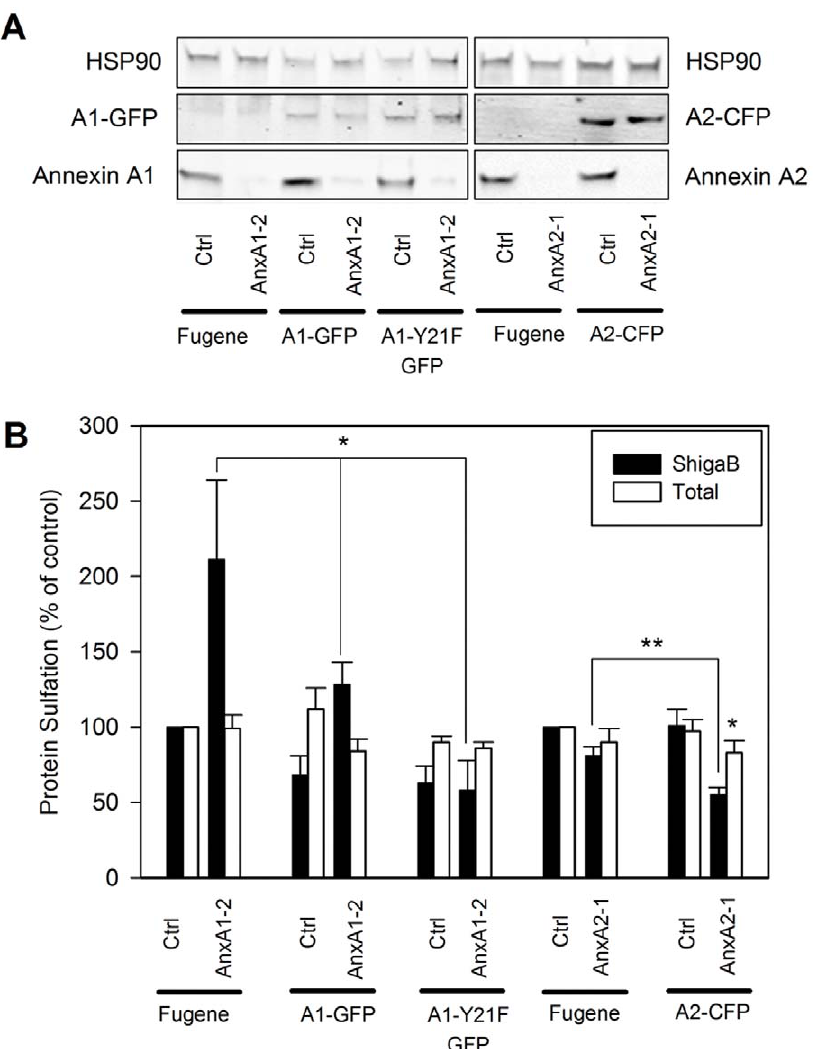
Figure 2. Rescue of phenotype by over-expression of wild type annexins. HeLa cells where transfected with indicated siRNA and subjected for 24 h either to Fugene treatment as control, A1-GFP, A1-Y21F-GFP or A2-CFP transfection as indicated. (A) Western blots of cells lysates for the conditions stated under each lane, stained with the indicated antibody and showing expression of constructs and/or endogenous annexins for one representative experiment (duplicates are not shown here for more clarity). (B) Quantative data from ShigaB sulfation (black bars) and total protein sulfation (white bars) are plotted as an average percentage of control values for at least 3 independent experiments, each performed in parallel, error bars indicating standard error of the mean; *p , 0.05 indicates statistically significant